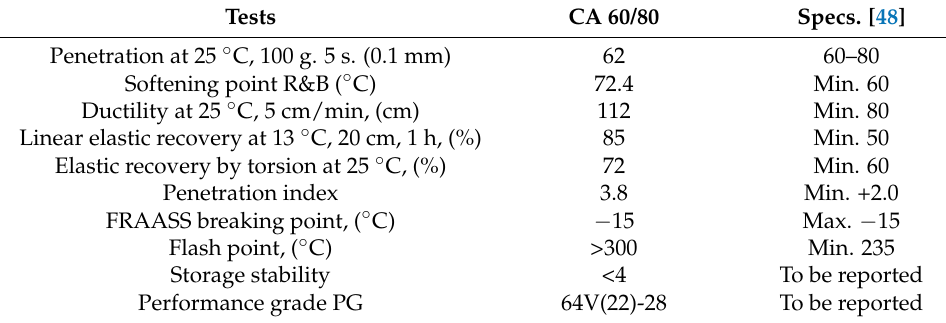
Figure 5. Temperature TGA profile of the cellulose commercial additive used in this study. Table 3. Properties of the asphalt binder